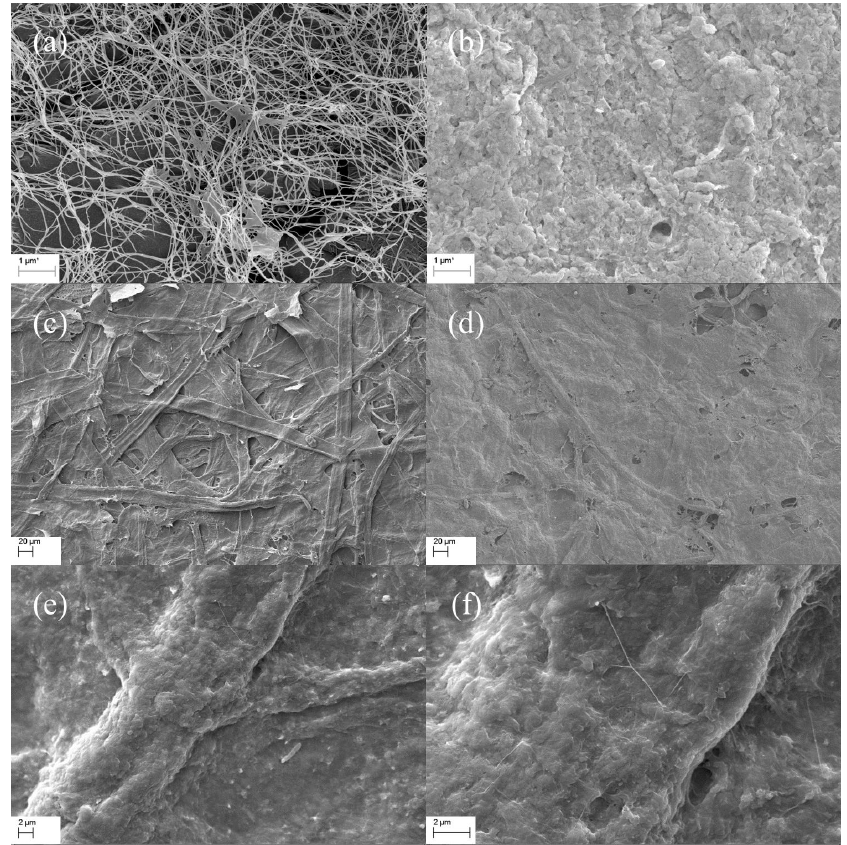
Figure 1. SEM images of ( a ) unmodified BC, ( b ) Eu-BC, ( c ) paper sheet made from sugarcane bagasse pulp, ( d ) Eu-BC fluorescent paper, and the cellulosic fibers on Eu-BC fluorescent paper at ( e ) 2K× magnification and at ( f ) 5K× magnification.